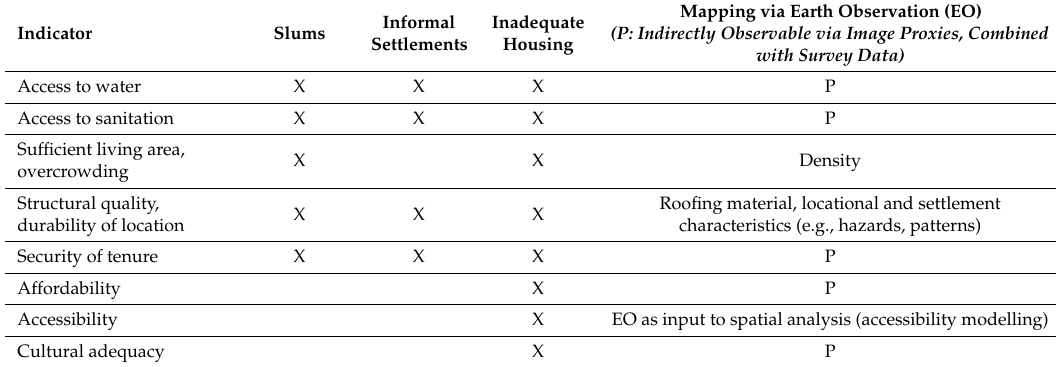
Table 1. Comparing slum, informal settlement, inadequate housing indicators, and the potential of remote sensing to capture these indicators in images (adapted from [3]).